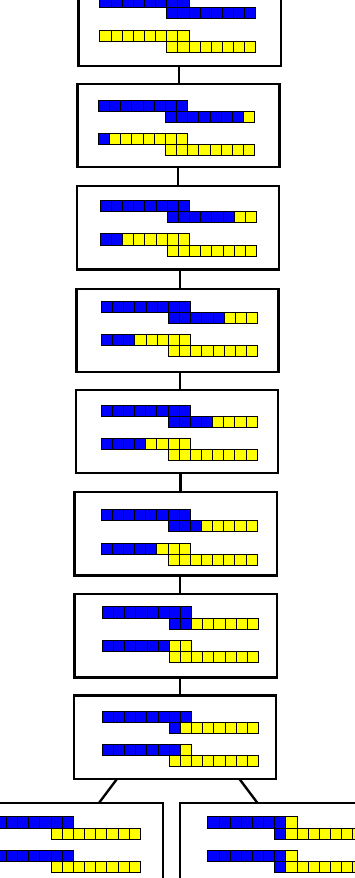
Figure 2. 5d rank one theories: box graphs for ( 2 ; 16 ) of SU(2) (cid:2) SO(16), for the marginal theory SU(2) + 8 F , which is shown at the top of the tree. Connections indicate ‘(cid:13)op transitions’, which in the gauge theory correspond to di(cid:11)erent phases of the extended Coulomb branch, and from the point of view of the SU(2) gauge theory, corresponds to decoupling fundamental